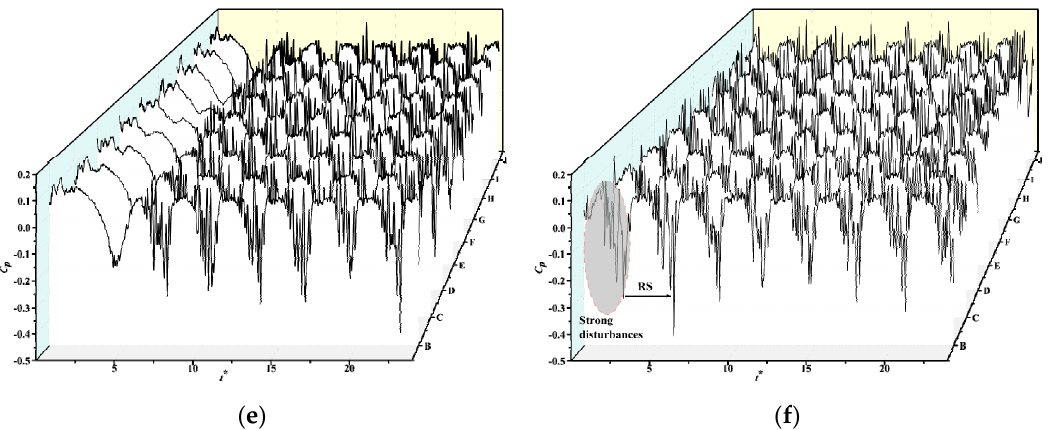
Figure 9. Pressure fluctuation characteristics of axial flow fan–operating point (OP) A–F. ( a ) ϕ = 0.189 − OP-A; ( b ) ϕ = 0.186 − OP-B; ( c ) ϕ = 0.183 − OP-C; ( d ) ϕ = 0.181 − OP-D; ( e ) ϕ = 0.178 − OP-E; ( f ) ϕ = 0.176 − OP-F.